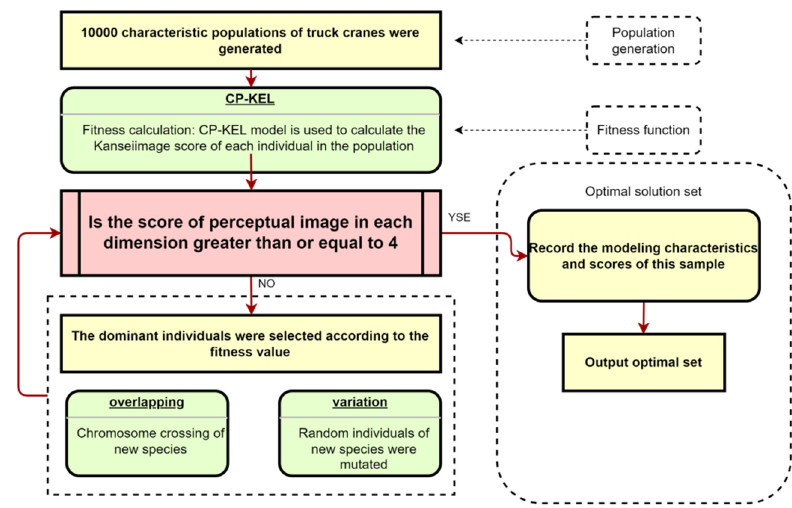
Figure 10. Flow chart of the GA model establishment.